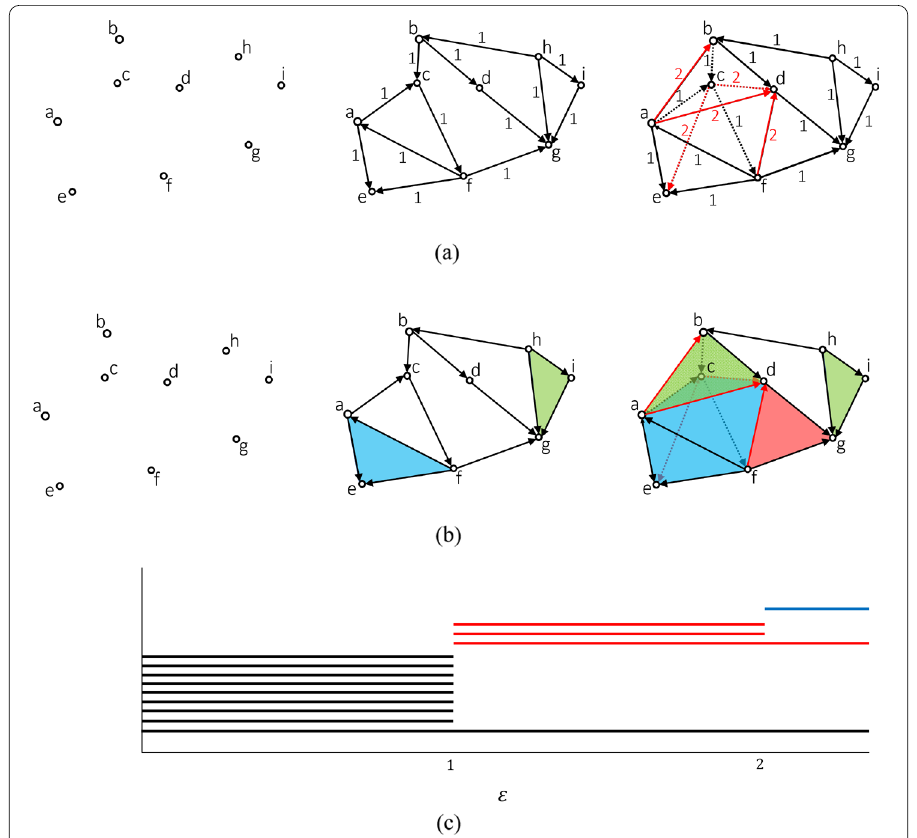
Figure 5 Two filtrations of the toy network. ( a ) A sequence of subnetworks paremetrized by edge weights. ( b ) Filtration of clique complexes induced by the sequence in ( a ). ( c ) The persistence barcode recording the birth and death history of distinct topological features in the complex: connected components (black bars), holes (red bars), and voids (blue bars)